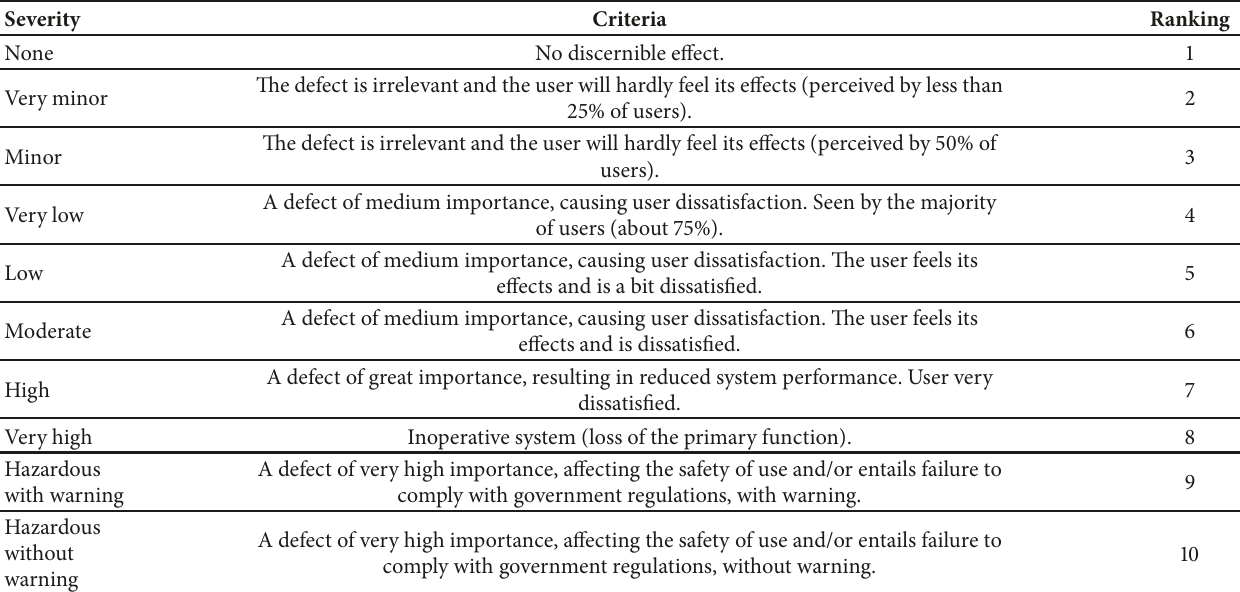
Table 4: Failure mode severity.